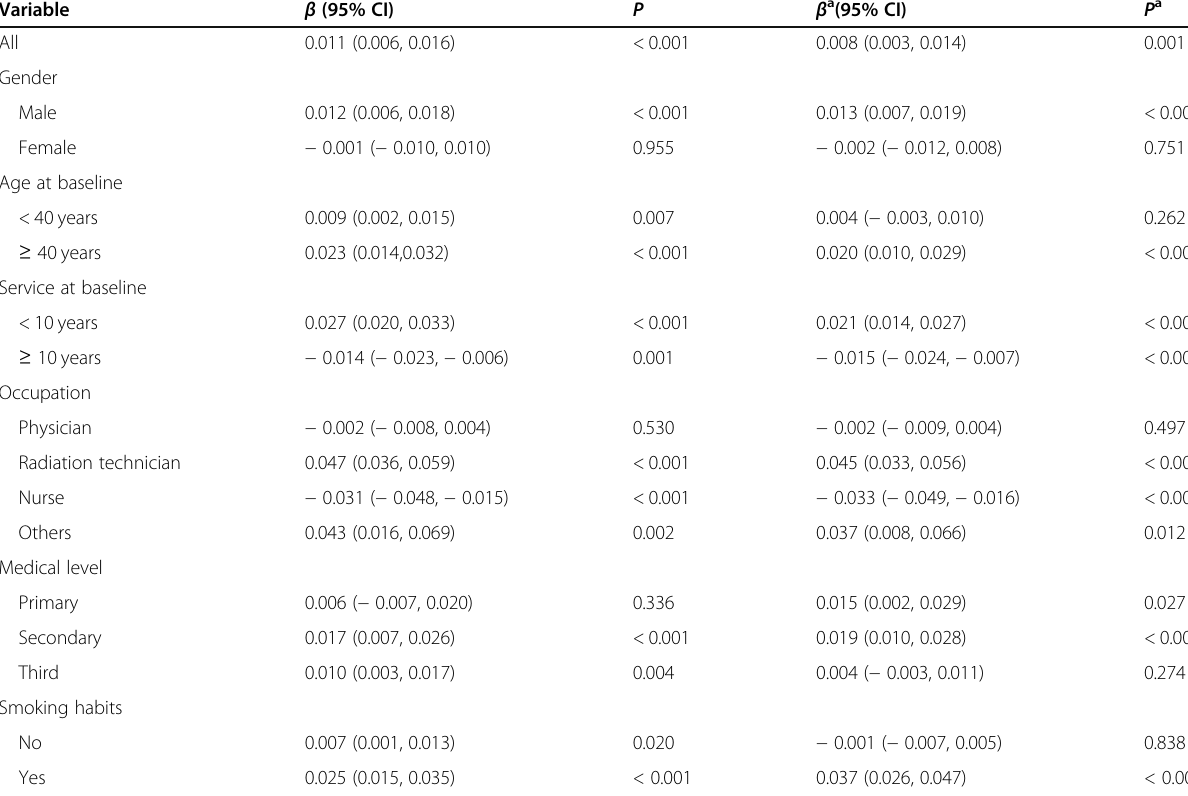
Table 2 Multivariate Poisson regression analyses for the biennially changes in platelets Variable β (95%